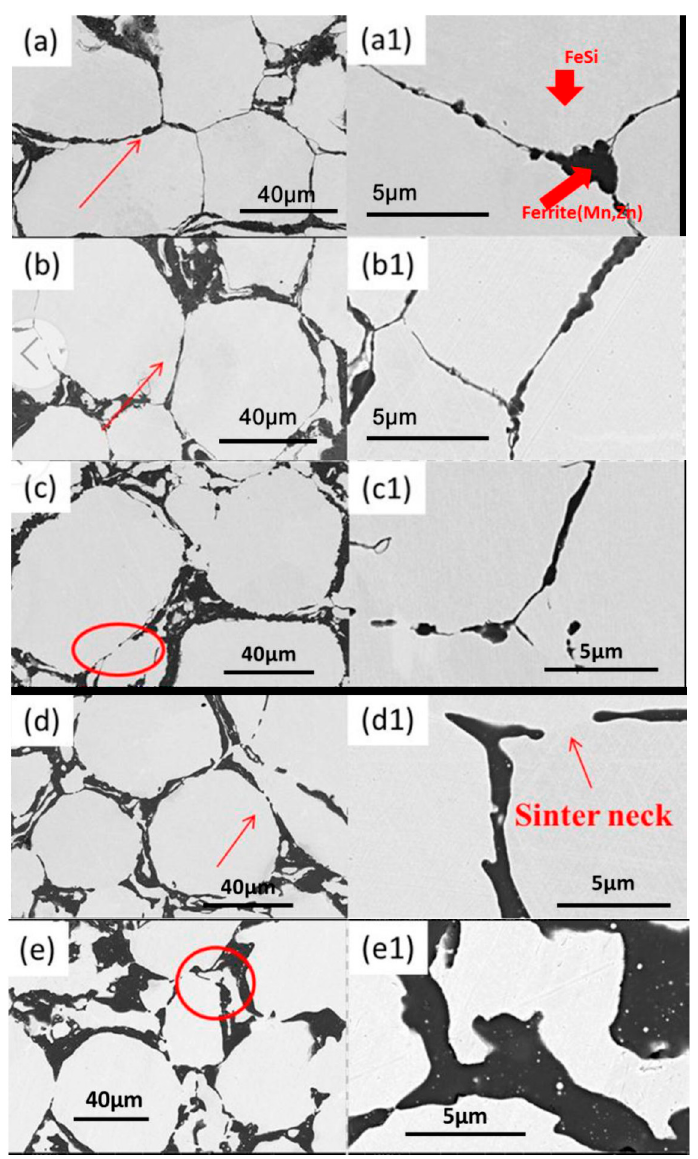
Figure 9. SEM micrographs of the Fe-Si/MnZn(Fe 2 O 4 ) 2 composites sintered at different temperatures (no corrosion): ( a ) 600 °C, ( b ) 700 °C, ( c ) 800 °C, ( d ) 900 °C, ( e ) 1000 °C.